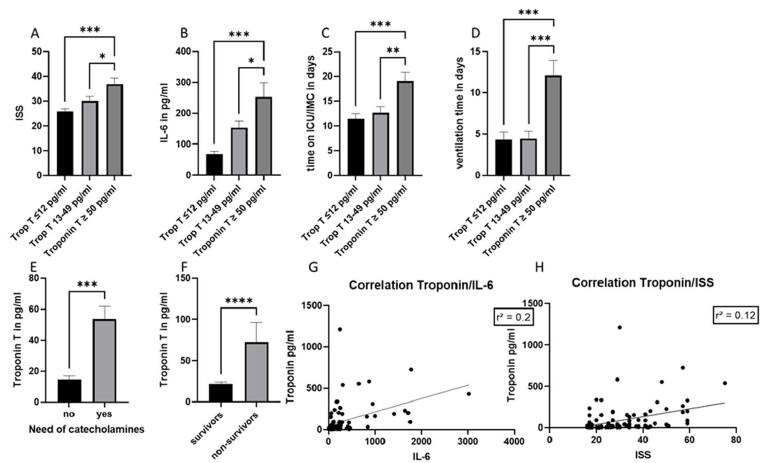
Figure 1. Relationship among ISS, IL ‐ 6, need in catecholamines and patient outcome with plasma troponin T. ( A ) Injury severity score (ISS) in the troponin subgroups of patients. ( B ) IL ‐ 6 concentra ‐ tion in the troponin subgroups. ( C ) Time on intensive care unit/intermediate care in days in the troponin subgroups. ( D ) Ventilation time in days in the troponin subgroups. ( E ) Troponin T con ‐ centrations in patients with (yes) and without (no) need in catecholamines. ( F ) Troponin concentrations in survivors and in non ‐ survivors. ( G ) Correlation analysis between troponin T and IL ‐ 6 measurements. ( H ) Correlation analysis between troponin T level and the ISS. n = 107 patients, * p ≤ 0.05, ** p ≤ 0.01; *** p ≤ 0.001; **** p ≤ 0.0001. Table 2. Polytrauma patients’ outcome, Troponin T subgroups. Groups (Troponin T, pg/mL)